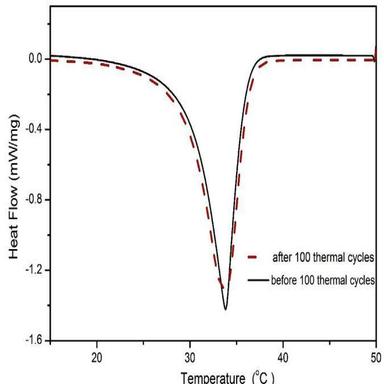
DSC curves of CaCl2·6H2O with CsxWO3 nanoparticles before and after 100 thermal cycle tests.